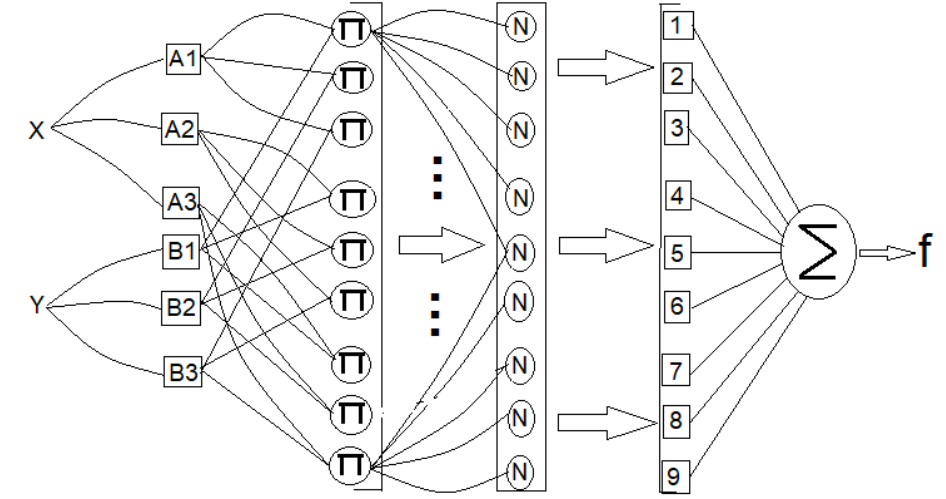
Figure 3. Two-input type 3 fuzzy